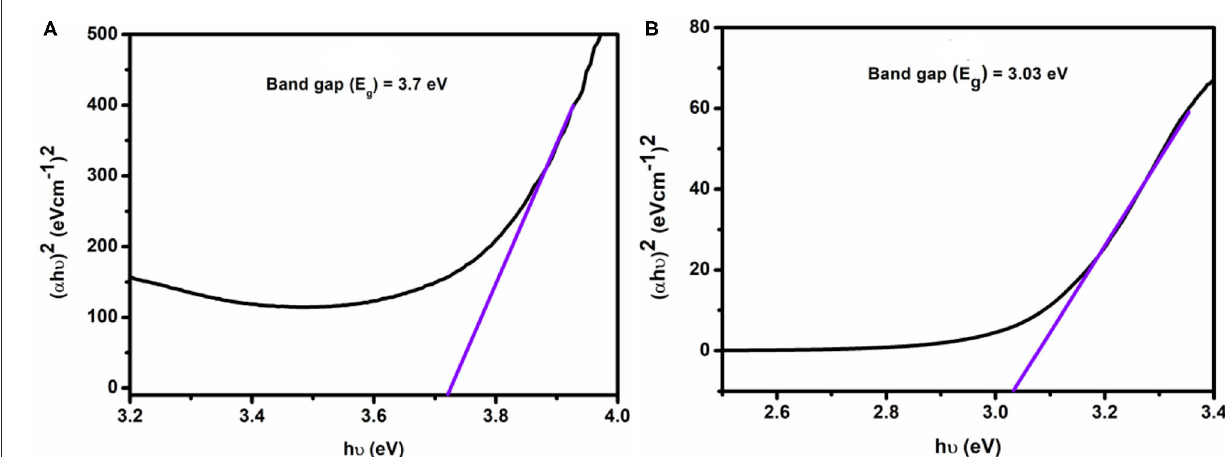
FIGURE 9 | Band gap energy of complexes 1 (A) and 2 (B) .